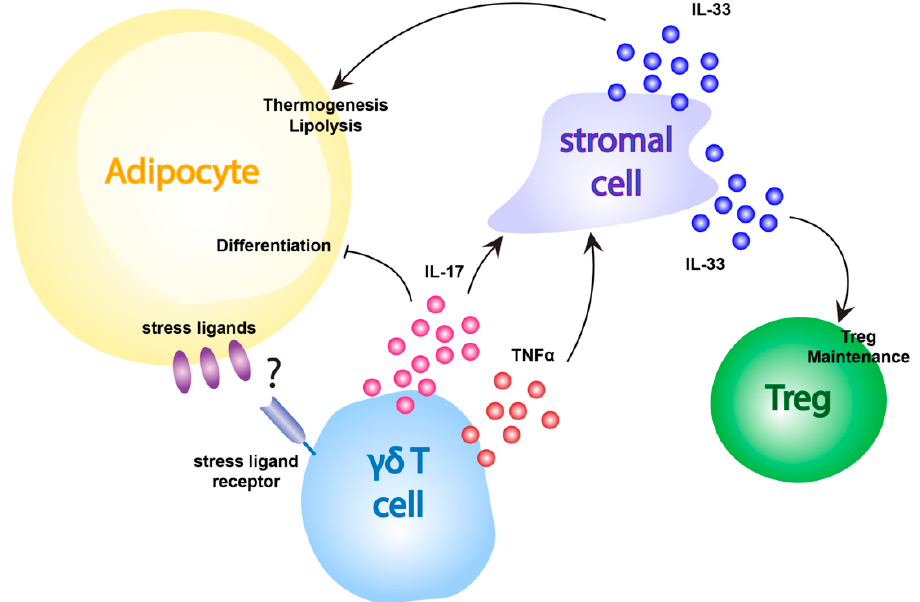
Figure 3. Adipose γδ T cell activation and function. Adipose tissue-resident γδ T cells a ff ect adipocyte metabolism and Treg maintenance through the release of IL-17 and TNF α which induce IL-33 production in stromal cells. This IL-33 acts to promote thermogenesis and lipolysis pathways in adipocytes of the BAT and inguinal WAT, and to maintain the Treg compartment in the adipose tissue. Additionally, γδ T cell-produced IL-17 appears to act directly on adipocytes to inhibit di ff erentiation. How γδ T cells become activated to perform these functions in unclear, but could rely on the recognition of stress ligands expressed by